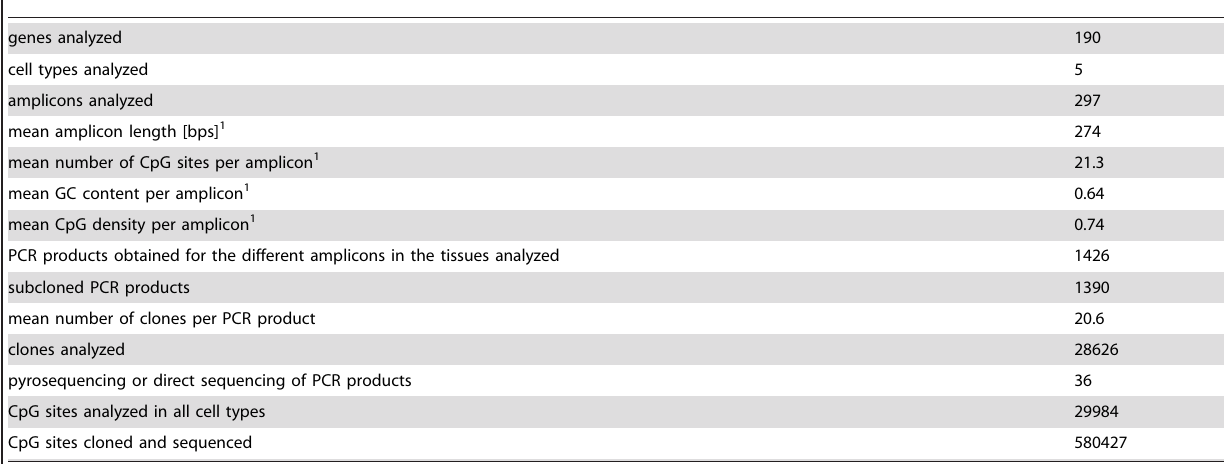
Table 1. Summary of the Data.